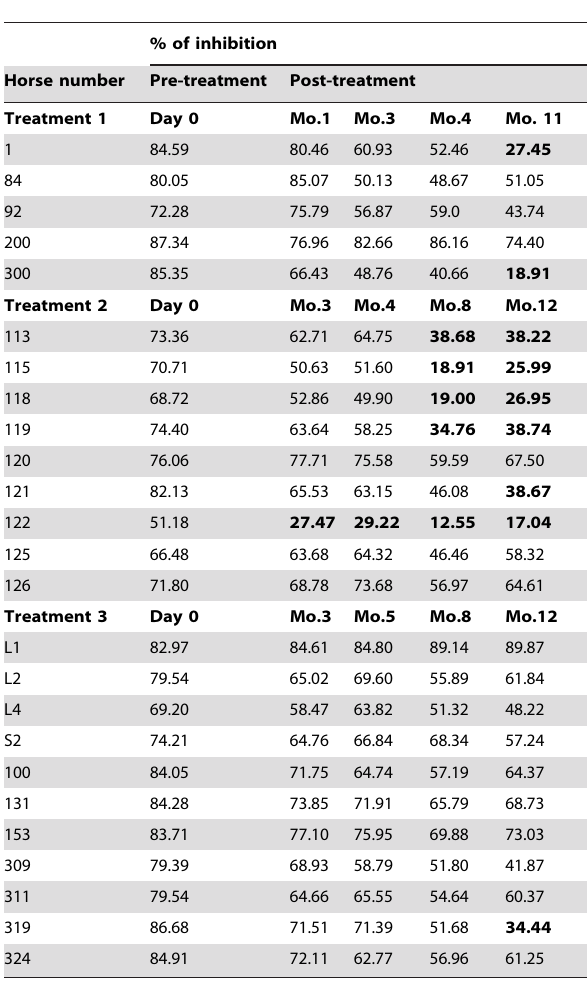
Table 3. Percentage of inhibition of specific horse antibodies to Theileria equi.